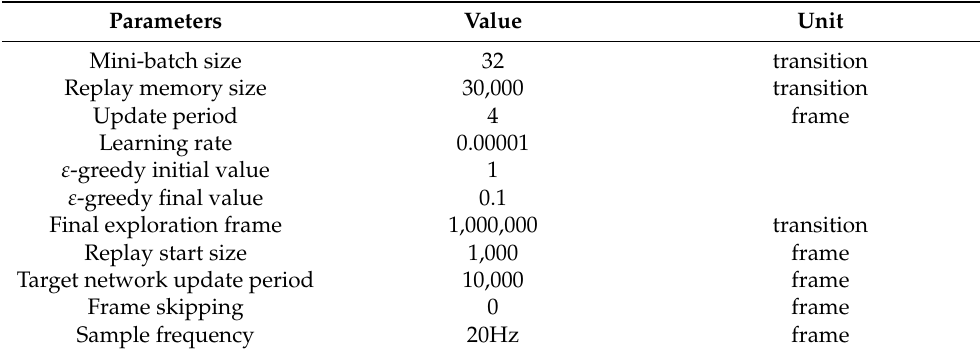
Table 15. The parameters setting of DQN with target network for our